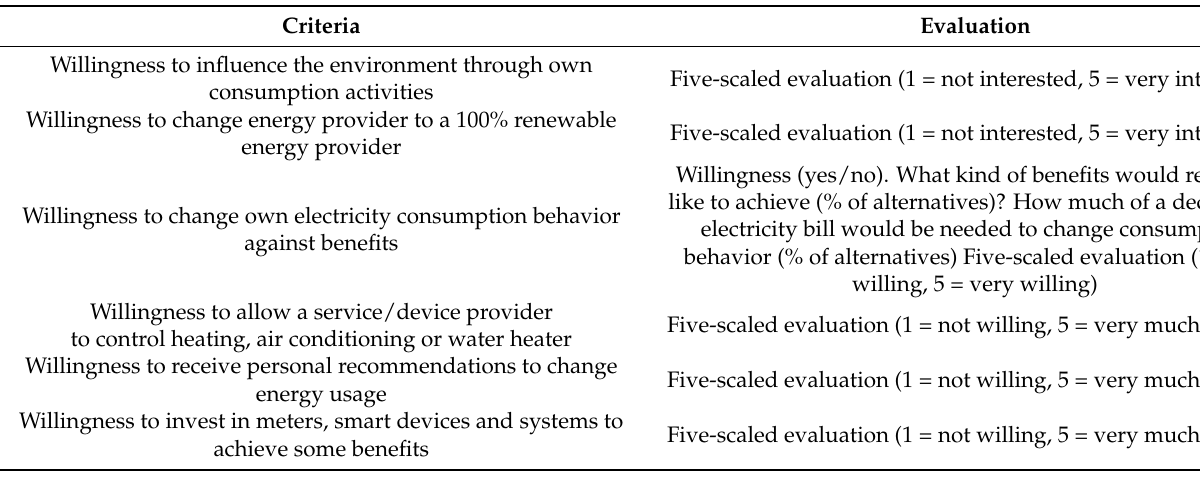
Table 3. Criteria to evaluate citizen engagement with climate conscious